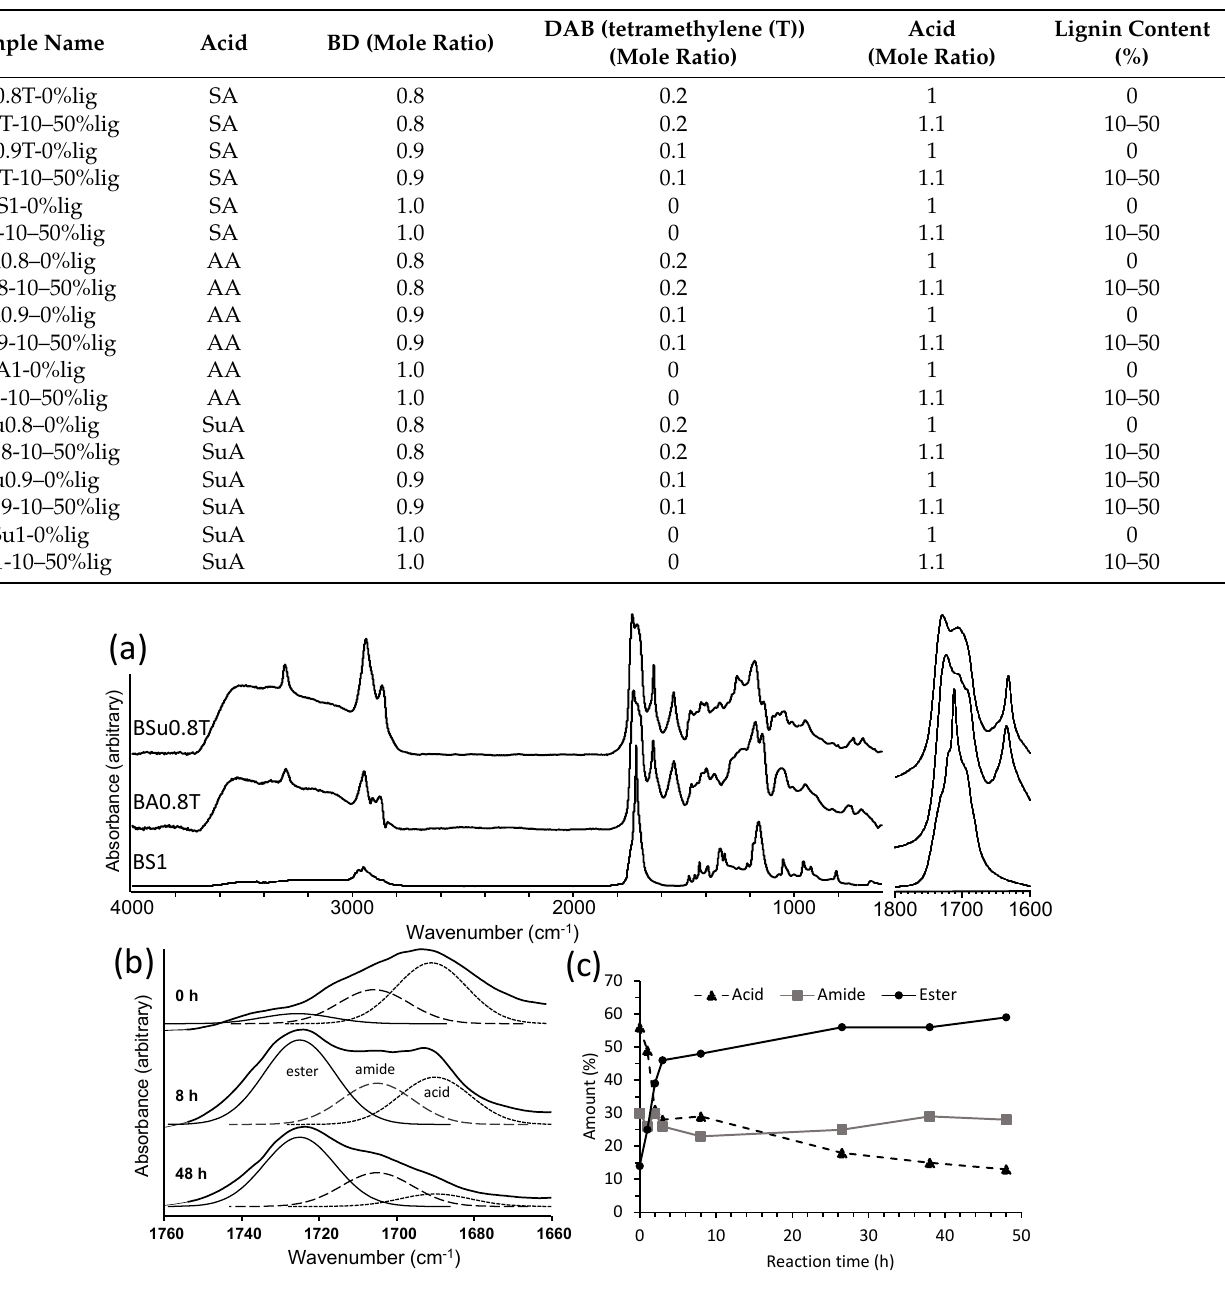
Table 1. Prepolymer and lignin-copolymer formulations with monomer composition and lignin content.